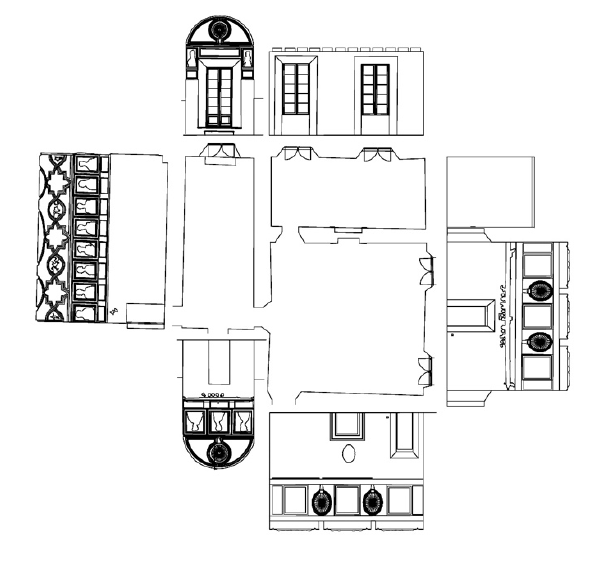
Figure 3. Internal elevations (sections) of the 3 rooms